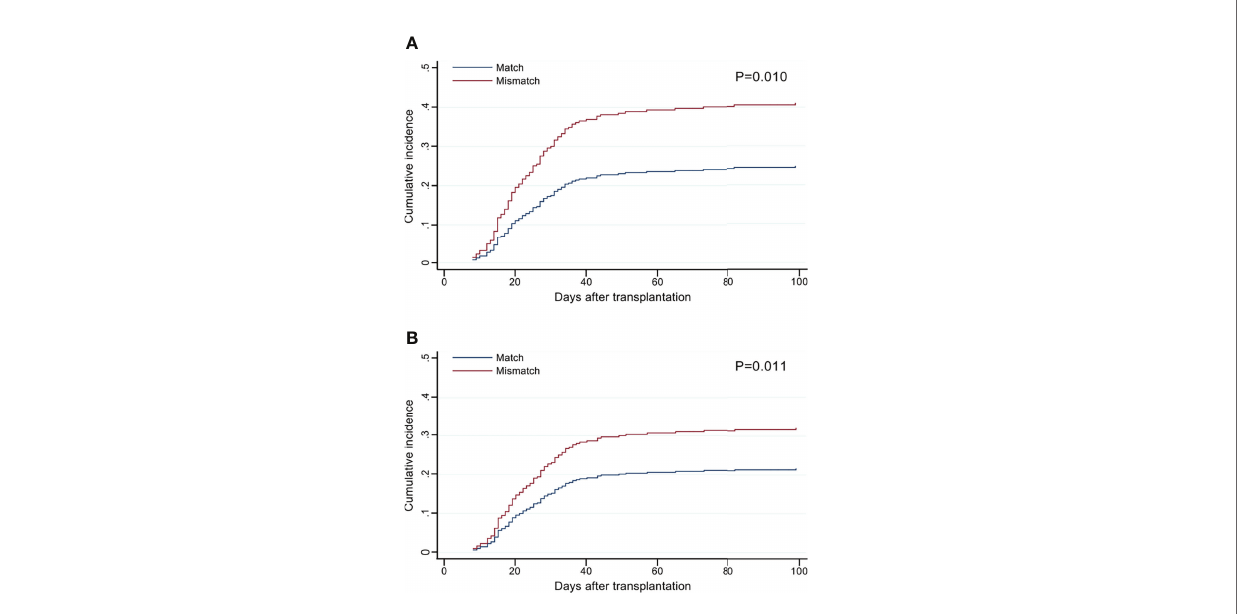
FIGURE 2 | Cumulative incidence of grade II – IV acute graft-versus-host disease (aGVHD) by the mismatch number of HLA-F-AS1 and HLA-DPB1 at the allele level in the GVH direction. (A, B) Cumulative incidence curves of HLA-F-AS1 and HLA-DPB1 , respectively. Cumulative incidences at 100 days were HLA-F-AS1 match,